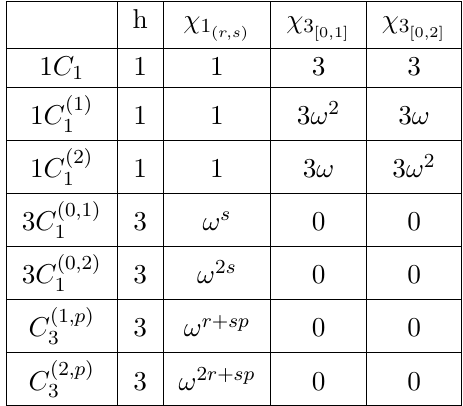
Table 5 . Characters of